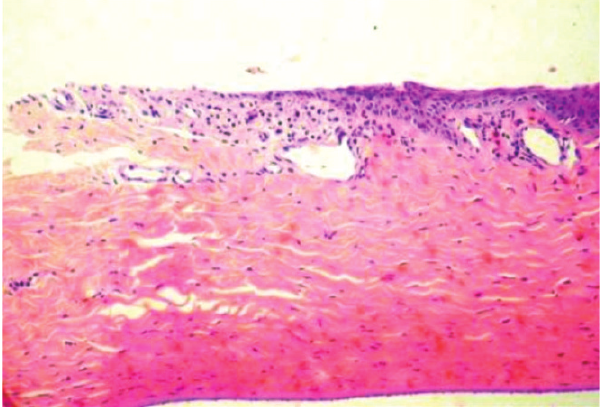
Figure 4 - Cornea from Animal 3 of the study group with little polymorphonuclear infiltration and full corneal epithelium